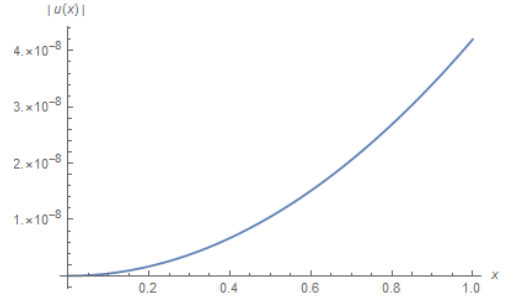
Figure 2:3D approximate Solution of example1 with (cid:11) = 1